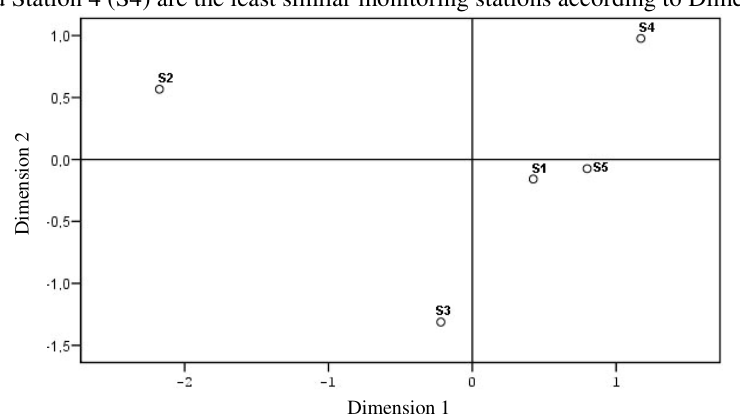
Figure 1. Multidimensional scaling analysis plot for the monitoring